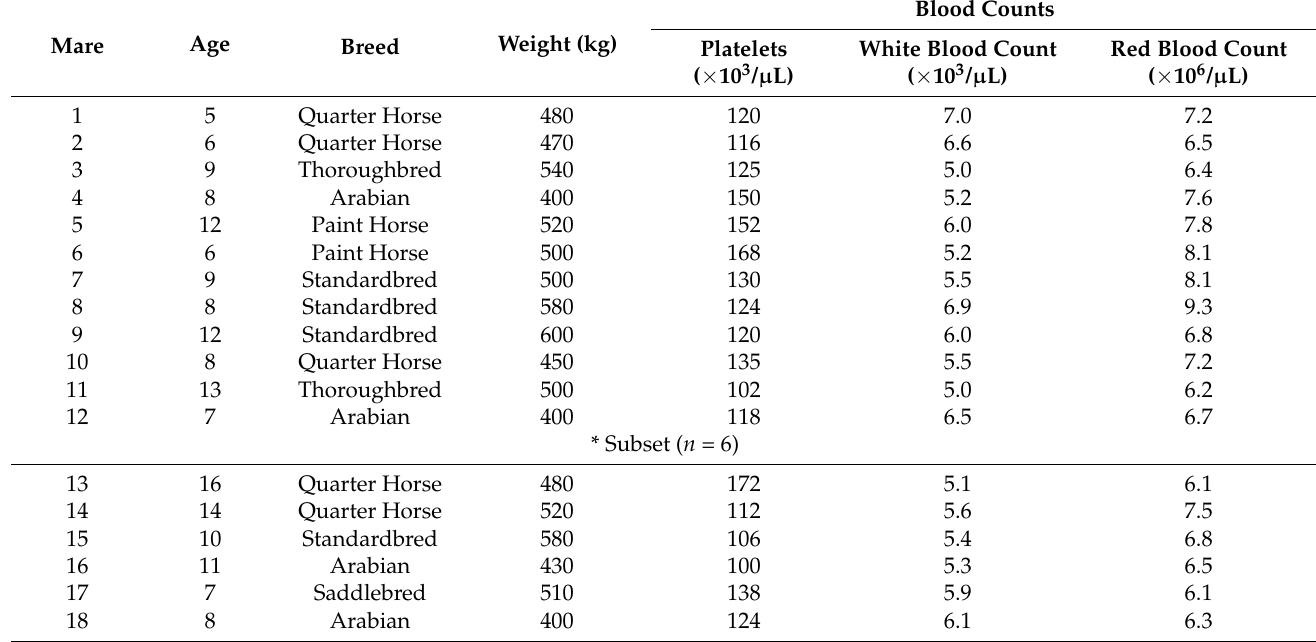
Table 1. Mare signalment and platelet and blood cell counting immediately